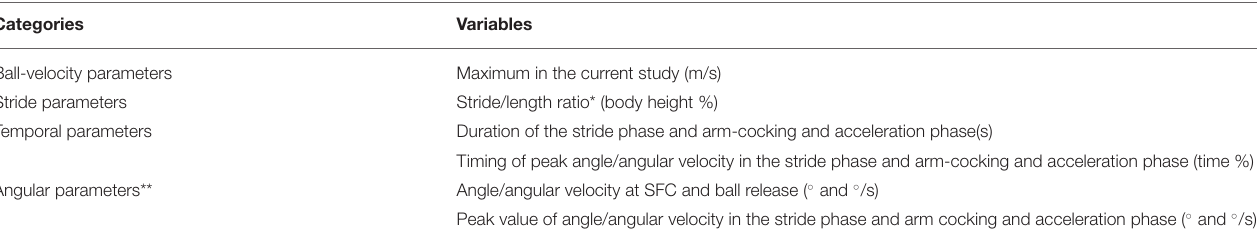
TABLE 1 | List of all parameters and variables evaluated in the current study.